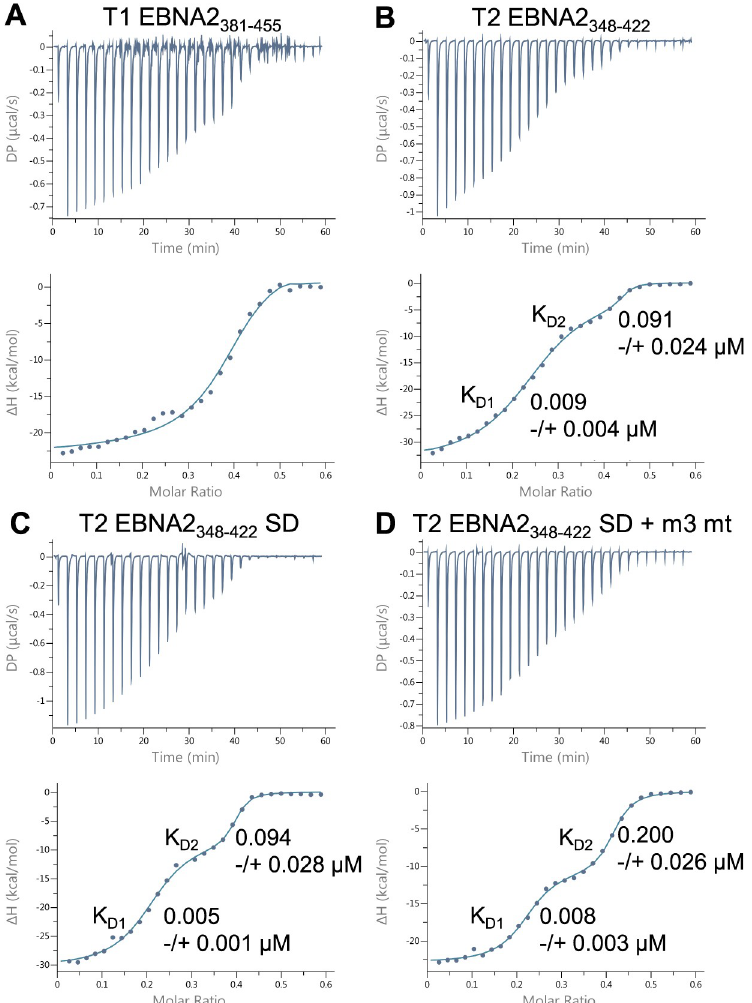
Fig 5. Isotheral titration calorimetry analysis of the interaction of type 1 and type 2 EBNA2 polypeptides with BS69 CC-MYND using an increased number of injections. ( A) ITC analysis of the binding of the type 1 EBNA2 polypeptide EBNA2 381-455 to BS69 CC-MYND. Titrations were performed using a series of 29 injections of 1.3 μ l 0.3 mM EBNA2 polypeptide and 0.1 mM BS69 CC-MYND in the cell. The solid line shows the best fit using a two-site (two event) binding model. The mean dissociation constant (K D ) ± standard deviation from 3 independent experiments is shown for each binding event. (B) ITC analysis of the binding of the type 2 EBNA2 polypeptide T2 EBNA2 348-422 to BS69 CC-MYND using 29 injections and fitting using a two-site (two event) binding model as in A. (C) ITC analysis of the binding of the type 2 EBNA2 polypeptide T2 EBNA2 348-422 SD containing the serine 412 to aspartate mutation using 29 injections and fitting using a two-site (two event) binding model. (D) ITC analysis of the binding of the type 2 EBNA2 polypeptide T2 EBNA2 348-422 with BS69 binding motif 3 mutated from PTLEP to ATAEA using 29 injections and fitting using a two-site (two event) binding model.